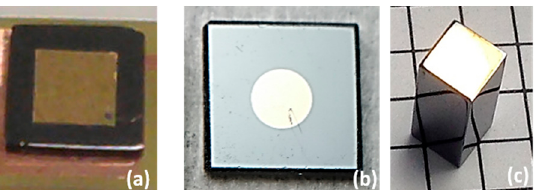
Figure 9. CZTS detectors in various detector configurations: ( a ) A planar 10 × 10 × 2 mm 3 with square contacts. ( b ) A 10 × 10 × 2 mm 3 single pixel with circular contacts. ( c ) A 4.4 × 4.4 × 10.7 mm 3 Frisch collar detector. The Frisch collar detector was fabricated at SRNL (Adapted with permission from ref. [49]. Copyright 2021, IEEE).